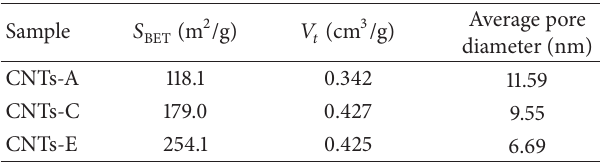
Table 1: Structural characteristics of the studied